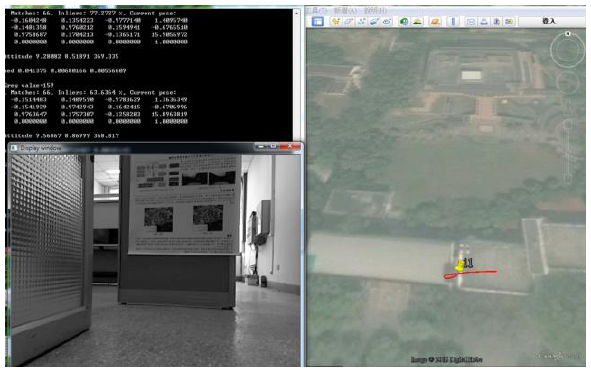
Figure 4. Visual odometry algorithm and real-time result in Google Earth